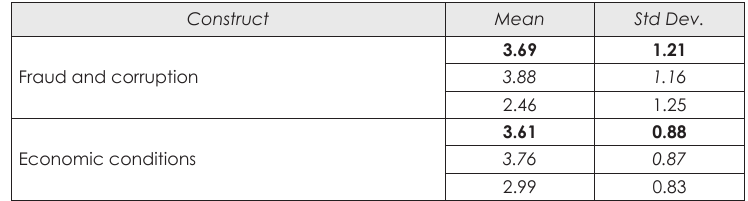
Aggregated means of perception constructs